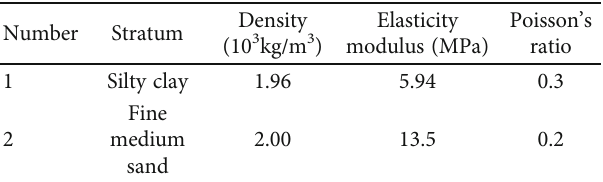
Figure 10: Initial model around pile No. 21+979. Table 1: Parameters of geological model around pile No. 21+979.